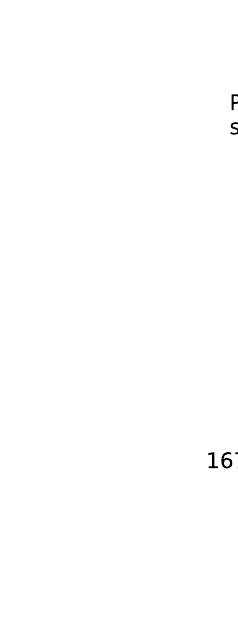
Figure 4. Block diagram of the photogrammetric set-up in the dynamic shaker system.